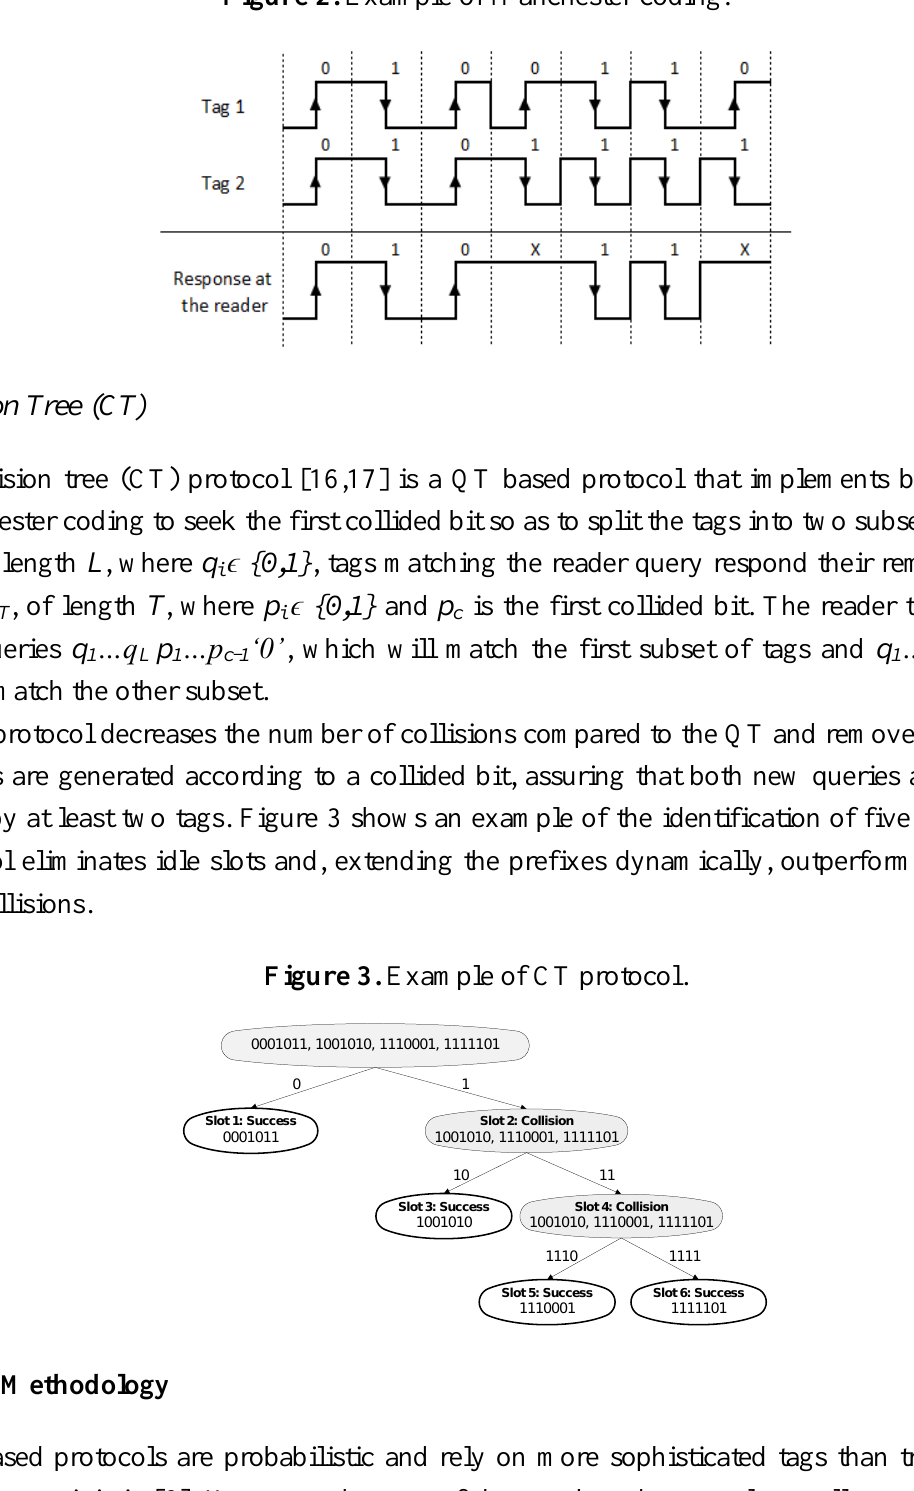
Figure 2. Example of Manchester coding.